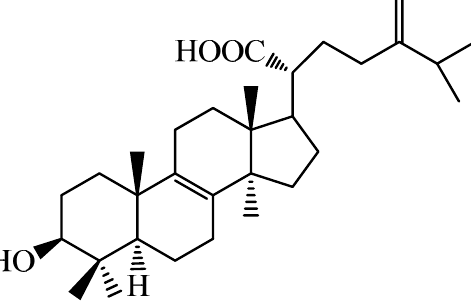
Figure 1. Chemical structure of eburicoic acid (TRR).